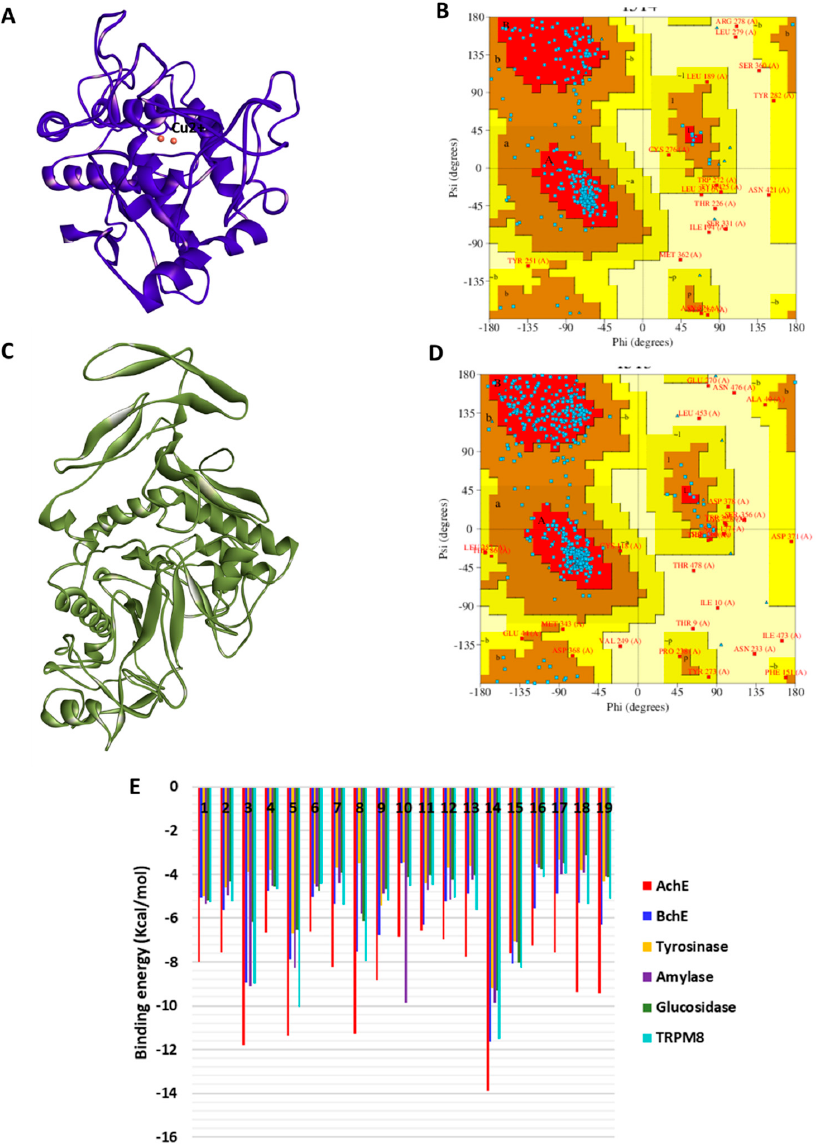
Figure 7. ( A ) Modeled structures of tyrosinase, and ( B ) its Ramachandran plot showing the energetically allowed regions for backbone dihedral angles ψ against φ of amino acid residues. ( C ) Modeled structures of α -glucosidase and ( D ) its Ramachandran plot showing the energetically allowed regions for backbone dihedral angles ψ against φ of amino acid residues. ( E ) Binding energy (docking score) values of the top bioactive compounds from Pelargonuim quercetorum . The compounds are displayed based on their serial number in Table 2.